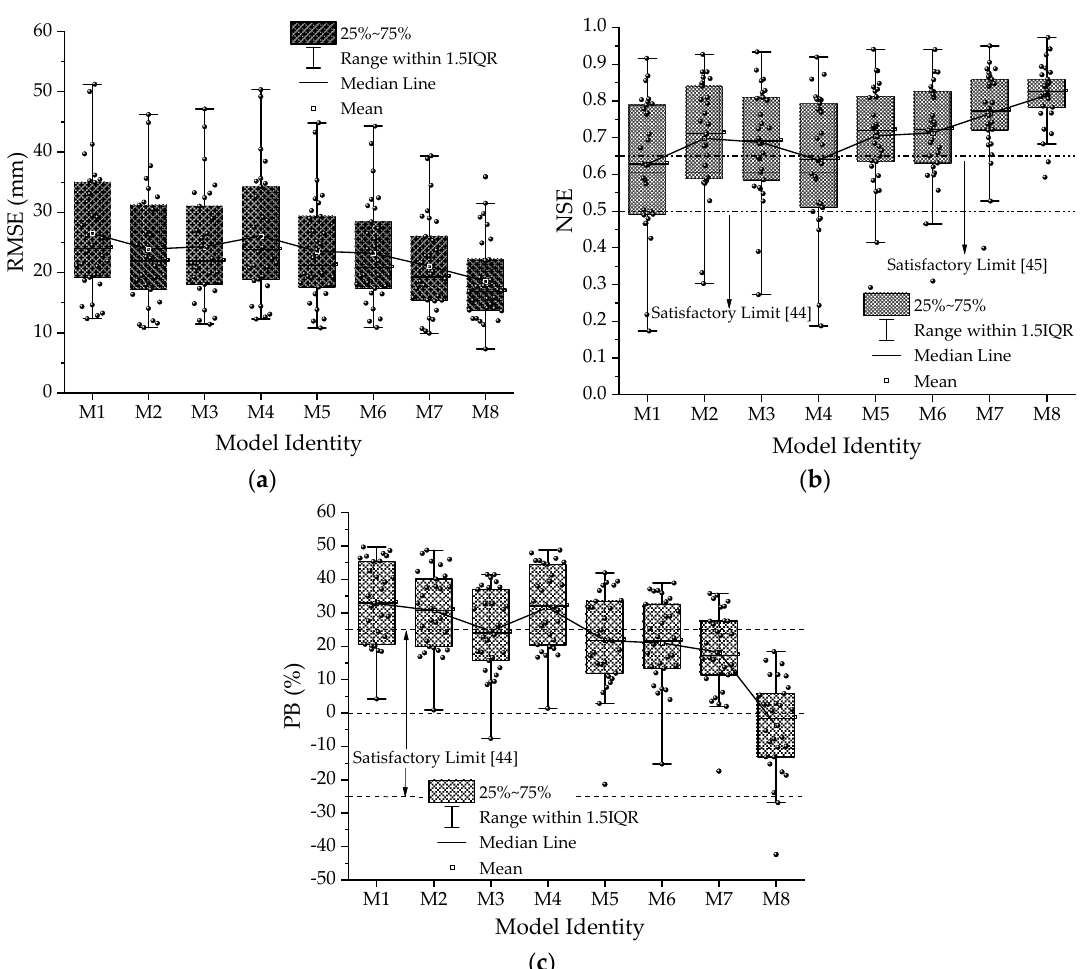
Figure 2. ( a ) Root mean square error (RMSE), ( b ) Nash – Sutcliffe efficiency (NSE), and ( c ) percent bias (PB) for eight variants of the CN model using data of 30 out of 31 calibration watersheds.